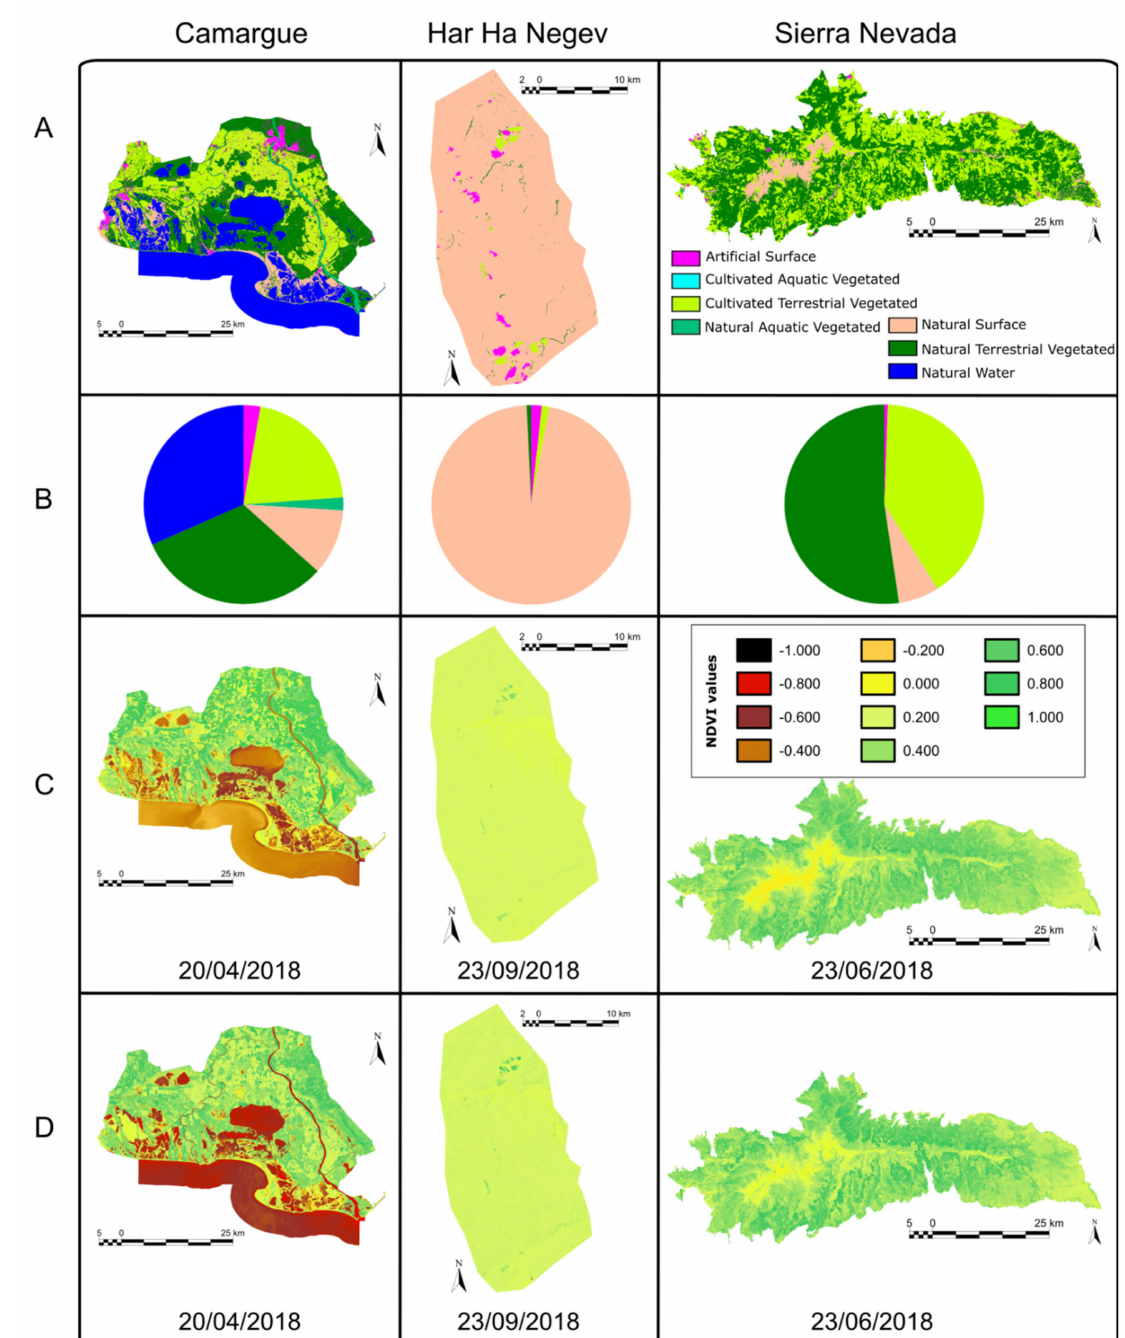
Figure 7. Protected areas studied in the Normalized Di ff erence Vegetation Index (NDVI) computation use case. ( A ) Land cover map for the PA, ( B ) pie charts with land cover distribution in the PA (legend in A also applies for B), ( C ) NDVI values for the first date, ( D ) NDVI values for the second date (legend in C also applies for